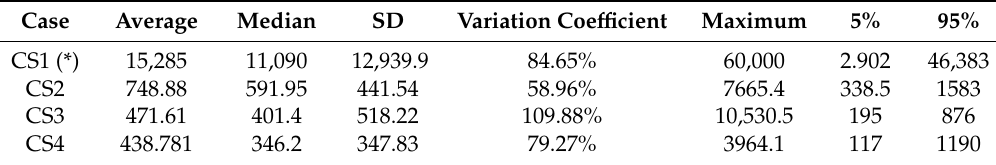
Table 12. Statistical data on the concentration of TVOCs (ppb) during lockdown.